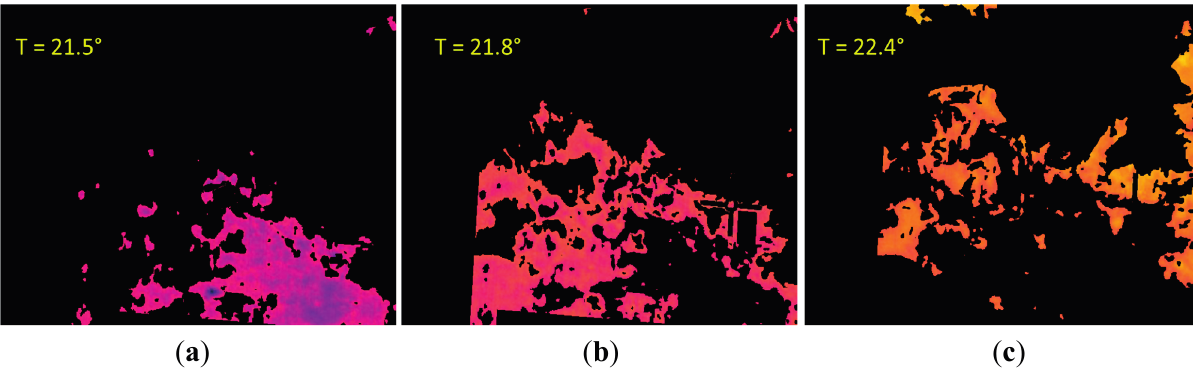
Figure 20. Effective clusters resulting from the K-means procedure. ( a ) First cluster; ( b ) Second cluster; ( c ) Third cluster.